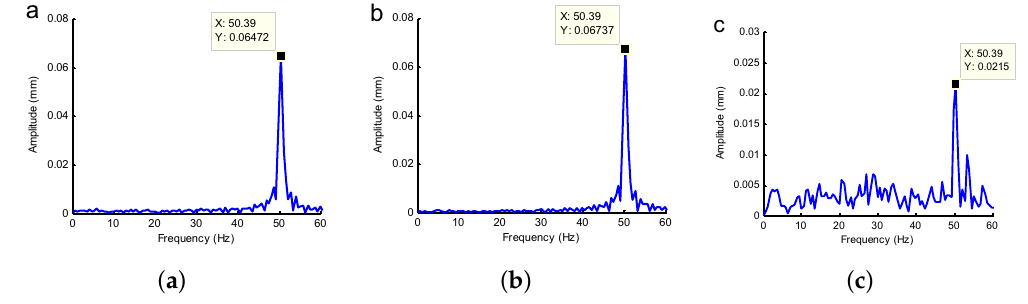
Figure 14. The frequency spectrum at rotation speed of 3000 rpm: ( a ) x direction; ( b ) y direction; and ( c ) z